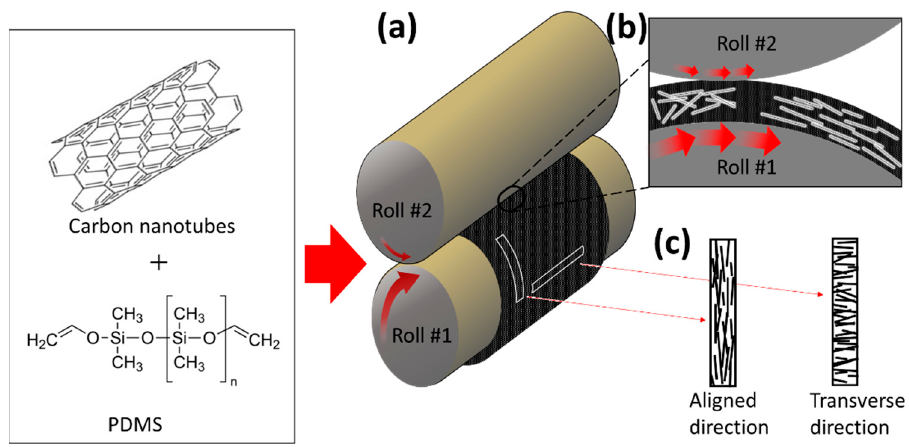
Figure 1. Fabrication scheme of the aligned multi-walled carbon nanotube (MWCNT) / PDMS composite. ( a ) Diagram of roll-to-roll milling. ( b ) The internal MWCNTs orientated in the circumferential direction, caused by shear force. ( c ) The aligned direction and transverse direction were obtained by cutting the film in the circumferential and axial directions, respectively .